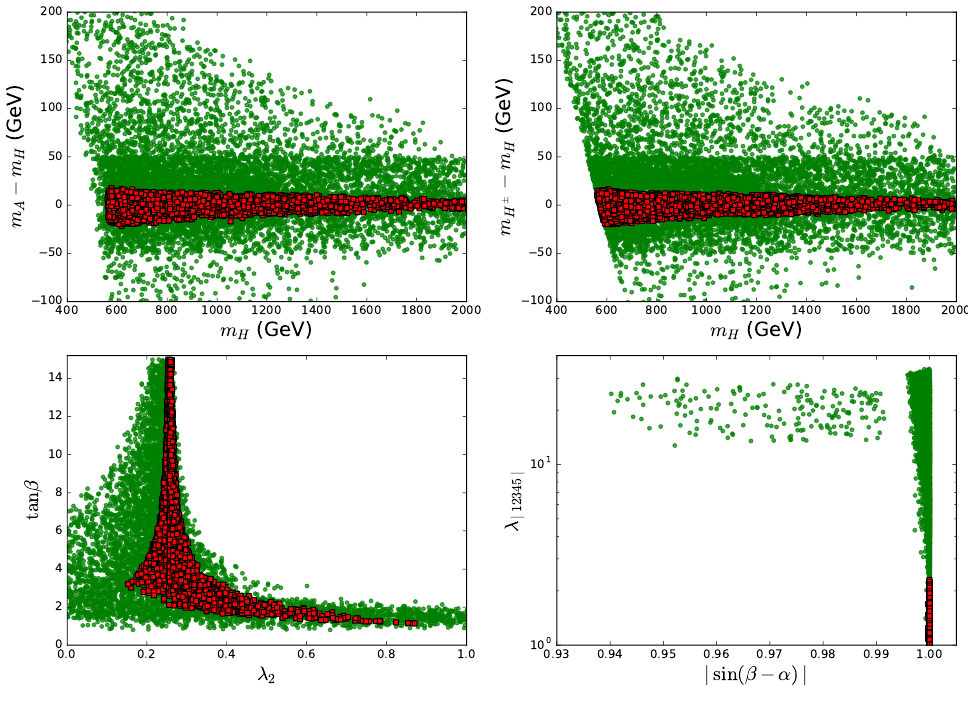
Figure 7 . For the type-II model, the bullets (green) satisfying the oblique parameters, the signal data of the 125 GeV Higgs, and theoretical constraints at the electroweak scale. The squares (red) satisfying the constraints of pre-inflation and h 2